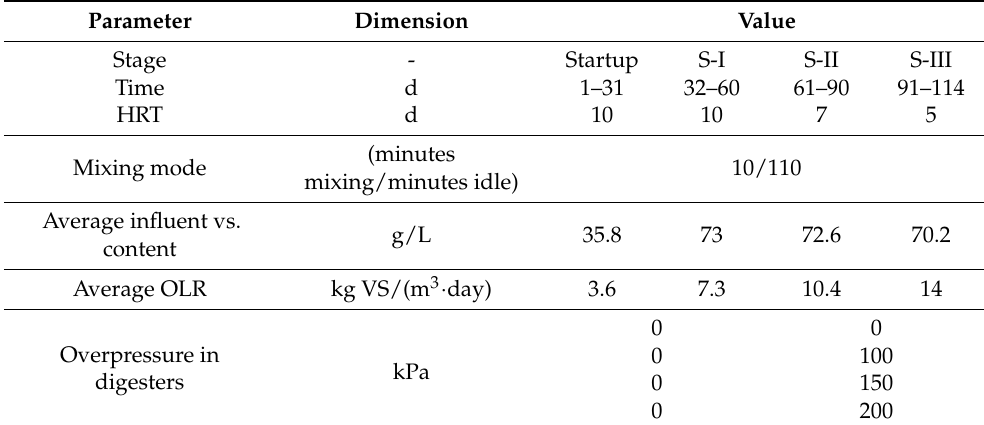
Table 2. Experimental plant operating